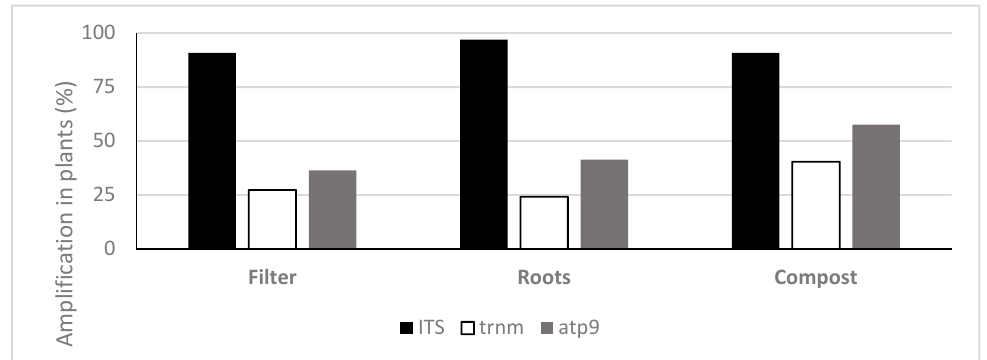
Figure 3. Frequency of detection of oomycete DNA using TaqMan probes on filters, roots and plant composts ( n = 99).